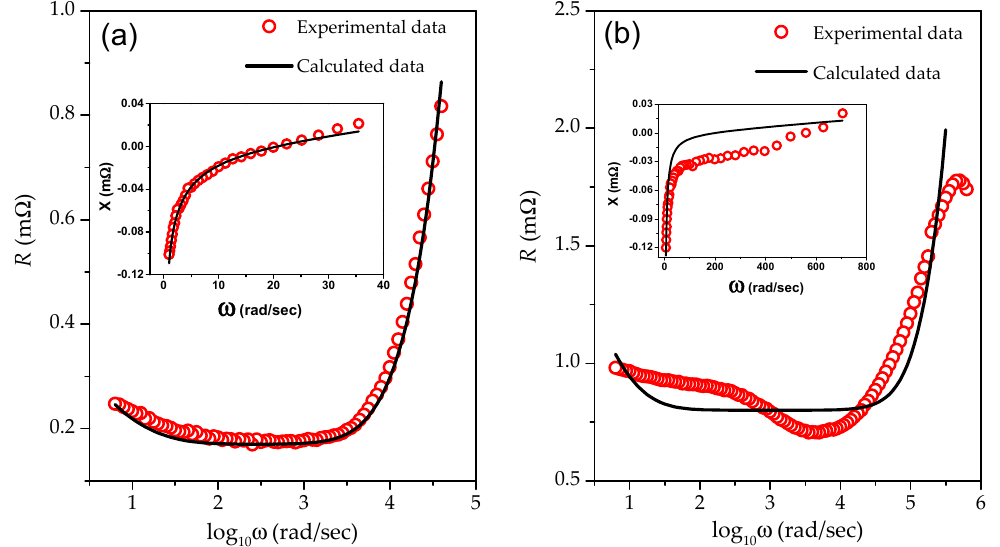
Figure 10. Experimental and calculated data of impedance for ( a ) symmetric double-layer UC and ( b ) asymmetric Li-ion UC.